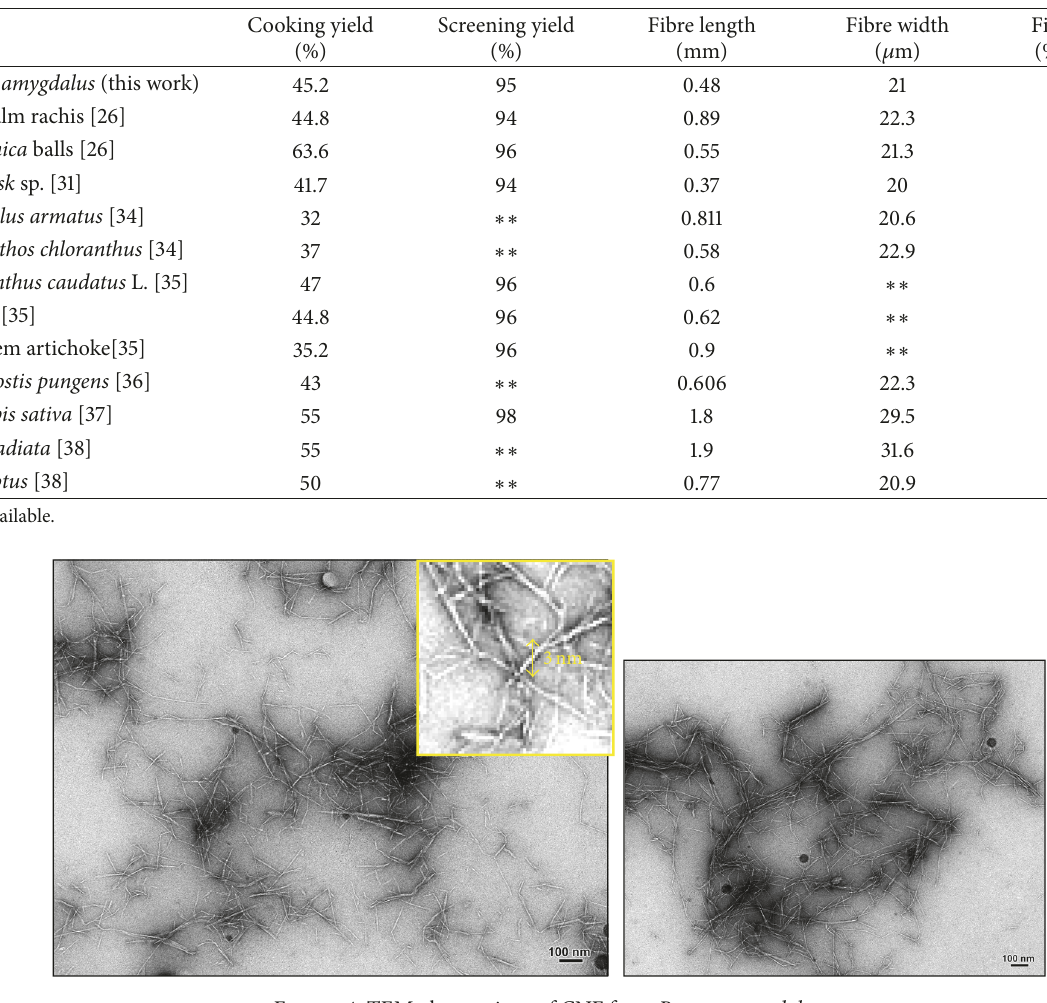
Figure 4: TEM observations of CNF from Prunus amygdalus